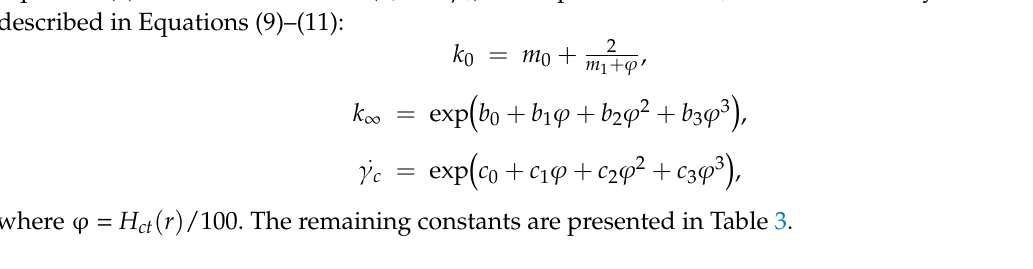
Table 3. Coe ffi cients used in Equations (9)–(11).